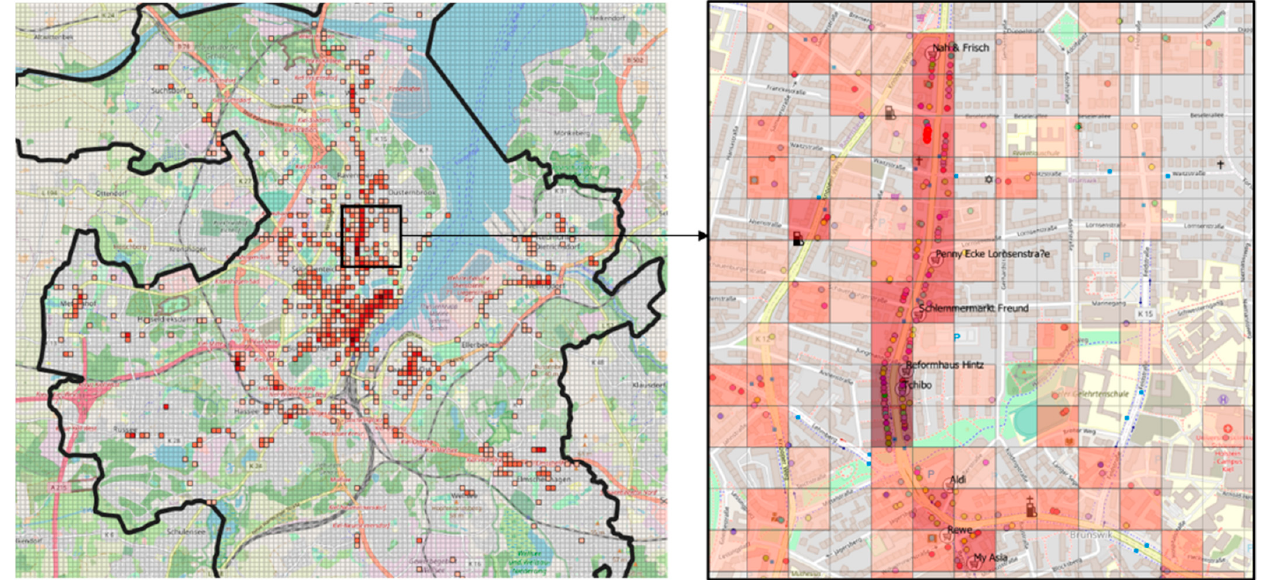
Figure A4. Identification of potential charging locations for the city of Kiel to be considered based on a 150 m × 150 m raster.